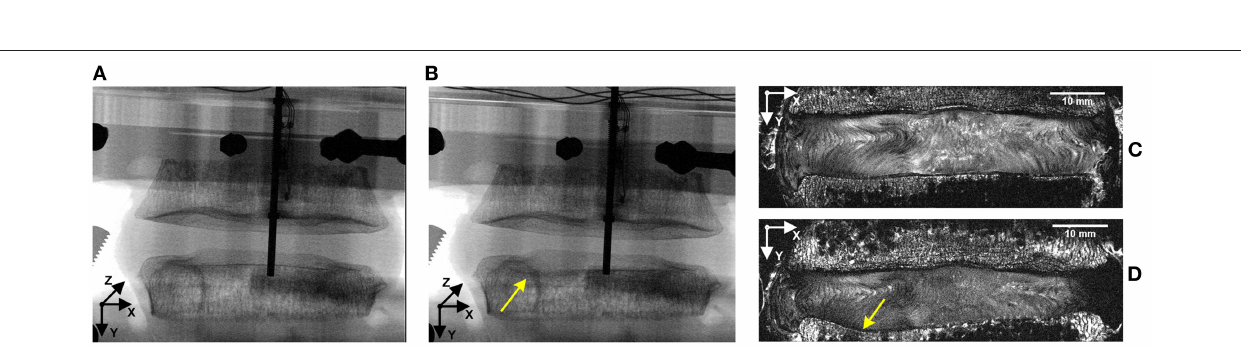
FIGURE 7 | Representative fluoroscope (A,B) and MR (C,D) images of a sample before (A,C) and after (B,D) fracture. Combining these two imaging modalities, along with manual dissection of each sample allowed the location of fracture to be identified, with the fluoroscope images being used to identify the initiation of the fracture and the MR images being used to precisely locate the fracture site on a transverse slice. Yellow arrows identify the location of